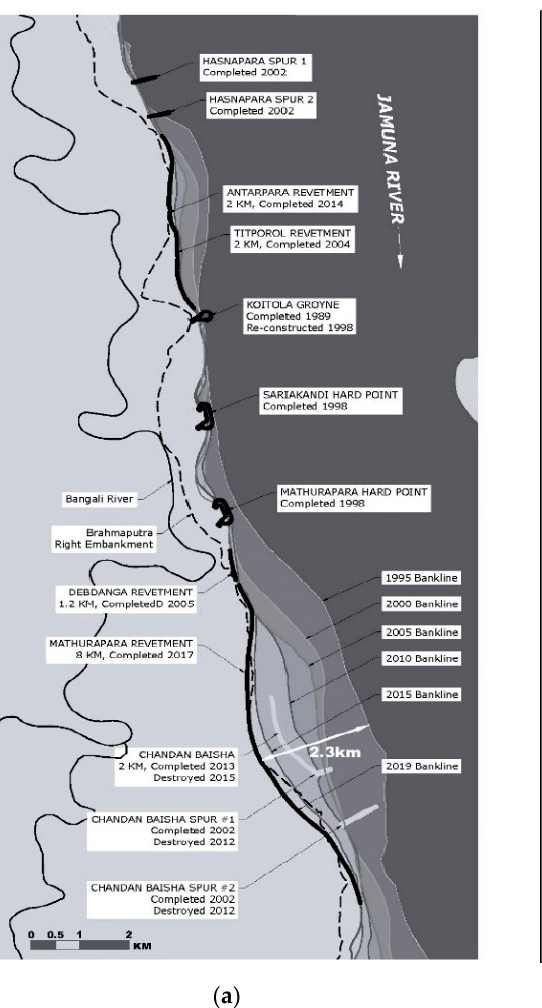
Figure 7. ( a ) “Hard point” concept at Sariakandi and Mathurapara with additional protection over 25 years. ( b ) Erosion around “hard points” at Bahadurabad and Guthail over 25 year.